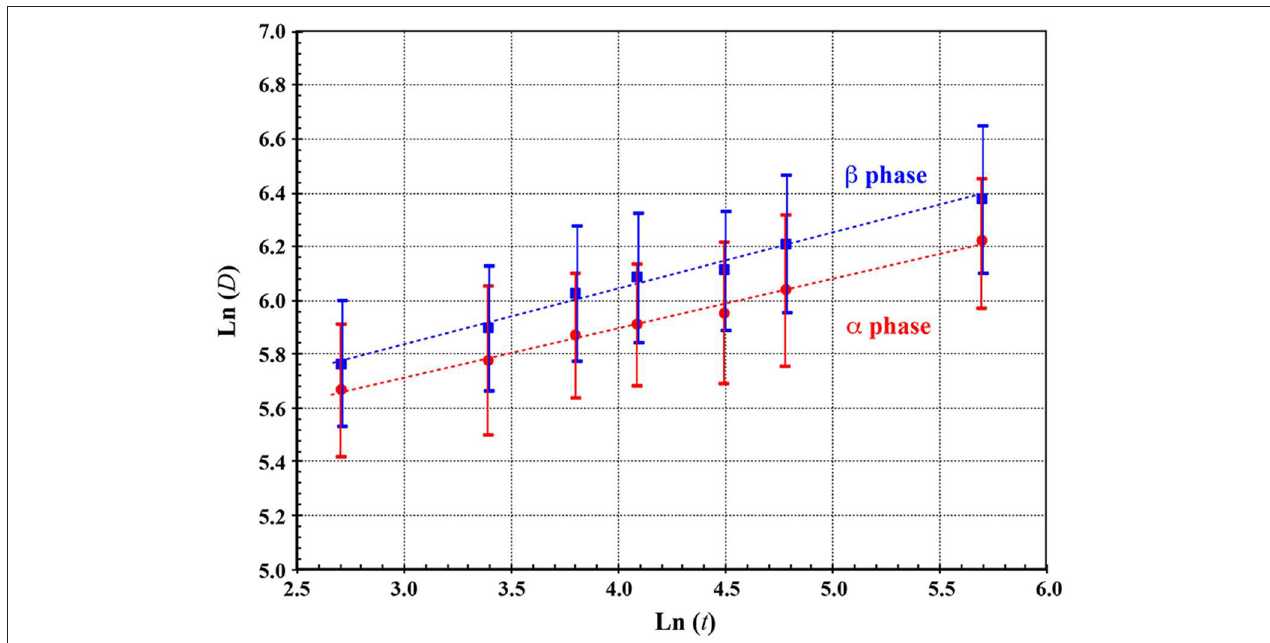
FIGURE 6 | Linear relationship between ln( D ) and ln( t ) for α and β grain growth of Ti35-5-5 at 650 ◦